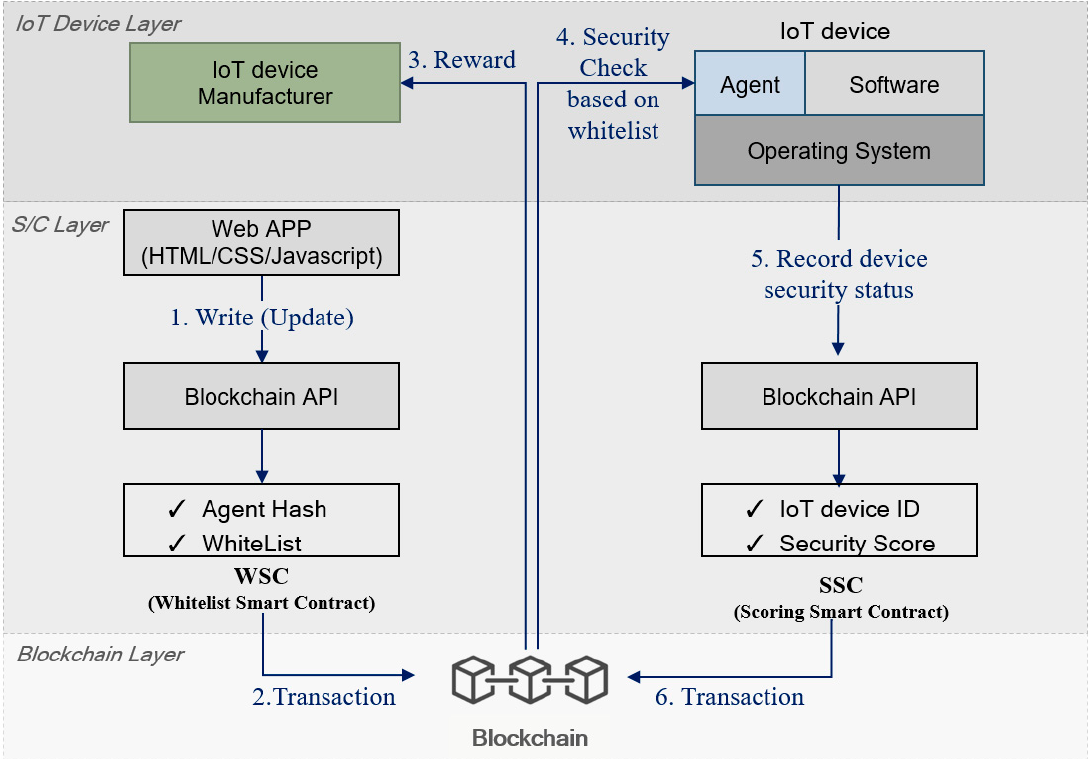
Figure 1. Security level evaluation mechanism for extending the Internet of things (IoT) networks based on a blockchain.